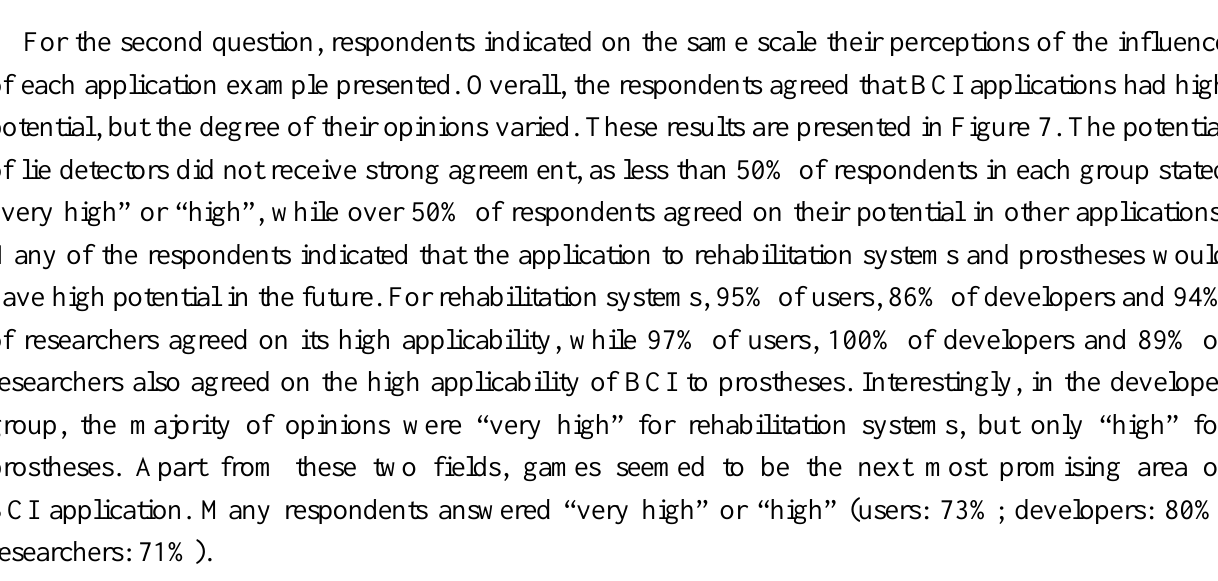
Figure 7. Respondents’ evaluations of the applicability of BCI in specific areas: users ( a ); developers ( b ) and researchers ( c